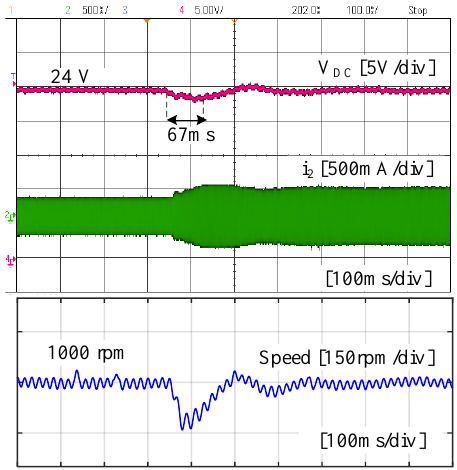
Figure 16. Transient waveform of the system at K = 0.4, P o step change from 2.5 W to 5 W for constant DC‑link voltage